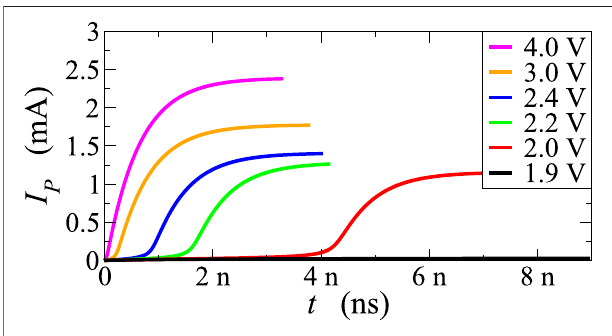
FIGURE 4 | Current fl owing across the PCM device as a function of time after the application of voltage steps of different amplitudes. The microscopic parameter τ n has been set to 0.6 ns.